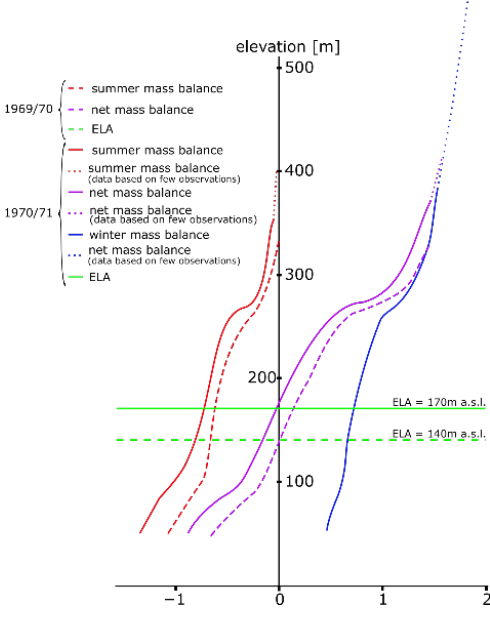
Figure 4. Track of RES measurements obtained in December 1995 by Macheret et al. [49] and the line of stakes obtained by Orheim and Govorukha [26].